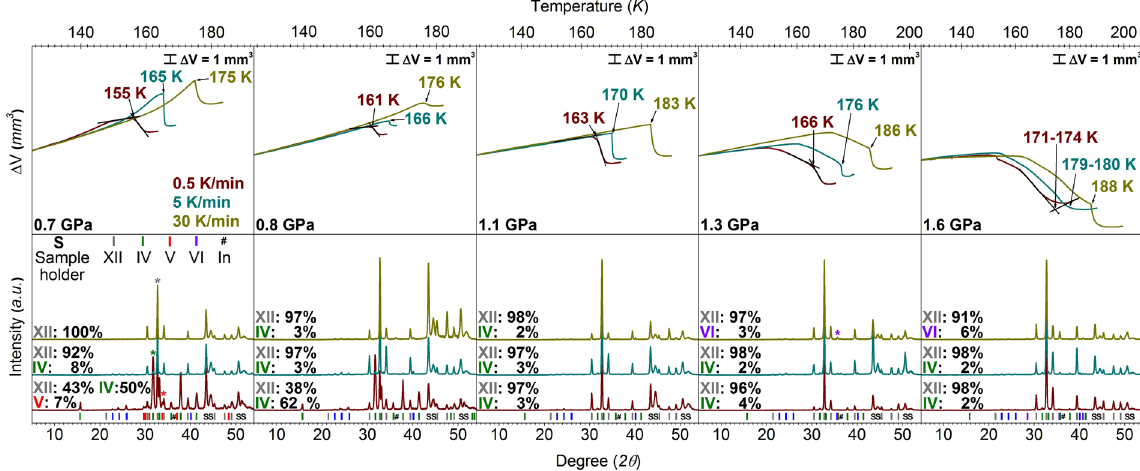
Figure 2. Isobaric heating of VHDA at different pressures p = 0.7–1.6 GPa. Samples were heated with different rates (depicted in respective colours) of 0.5 (dark red), 5 (cyan) and 30 K min − 1 (dark yellow). In the upper panel the volume curves Δ V vs. temperature T are shown. Crystallisation temperatures T x were usually identified by rather steep steps in the volume curve indicating transformation to denser crystalline phase mixtures and are labelled with the respective temperature values. In the lower panel powder x-ray diffractograms recorded ex situ are shown. The results from separate experiments with different heating rates are stacked for clarification. Relative yields of crystalline ices in the phase mixtures are indicated by percentages and the respective most intensive Bragg peaksmarked in the diffractograms with different colours (ice V in red, ice IV in green, ice XII in grey and ice VI in